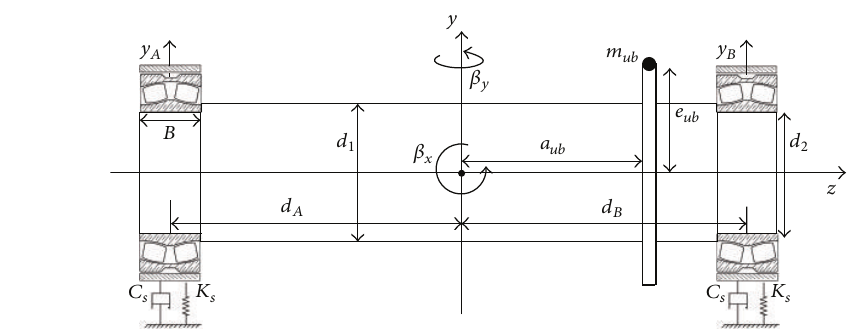
Figure 11: Effect of roller position on bearing force.